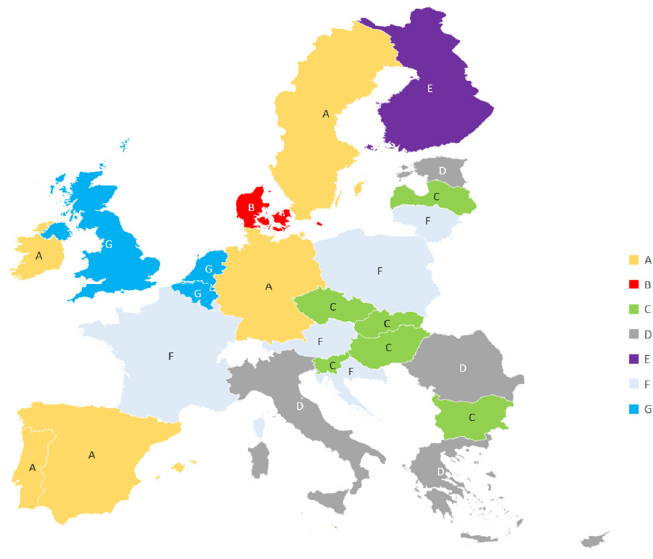
Figure 9. Division of the EU countries into clusters.